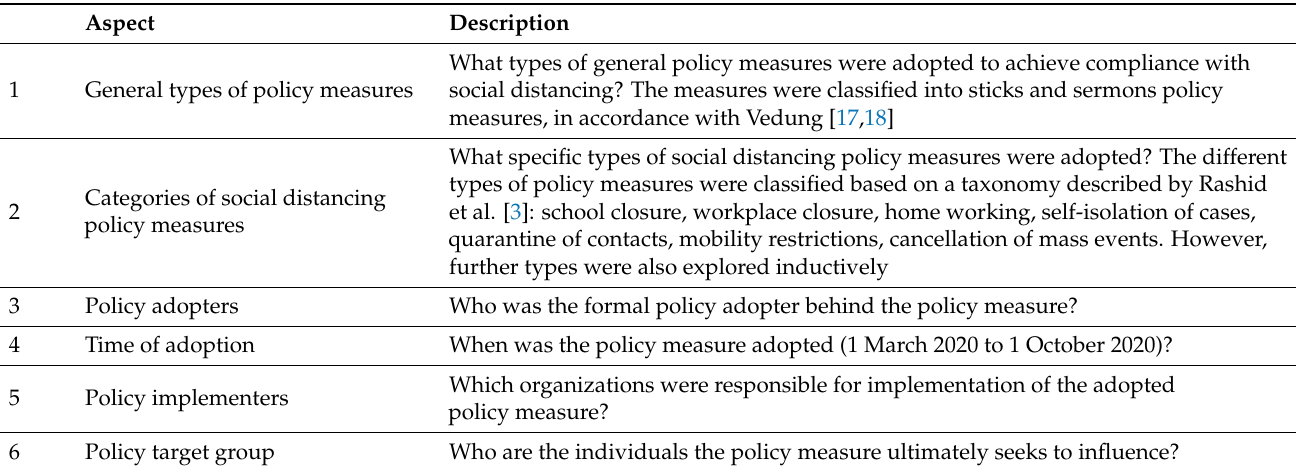
Table 2. Aspects of the policy measure documents